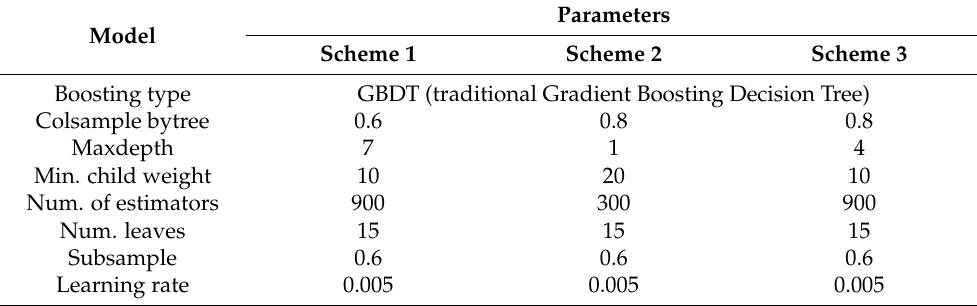
Table 2. Parameters of LightGBM